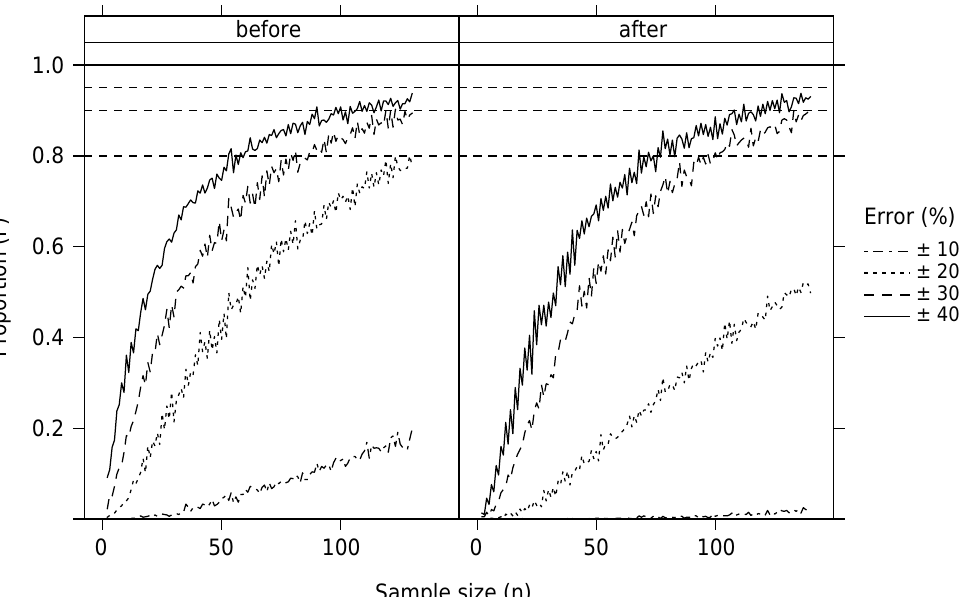
Figure 5. Proportion of bootstrap vertical profiles of sample median of cone index (CI) values that fall within the ± 10, 20, 30, and 40 % of error around the vertical profile of mean CI values, before and after tillage.